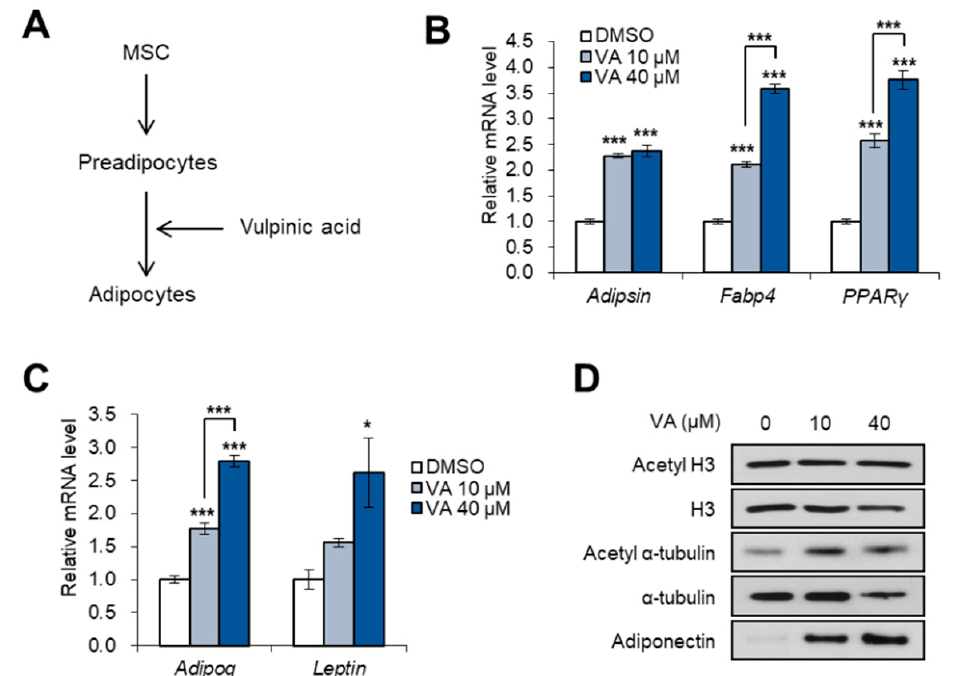
Figure 4. Vulpinic acid promotes adipogenesis from 3T3-L1 preadipocytes. ( A ) Schematic representation of adipogenesis process. 3T3-L1 cells were incubated with an adipogenic medium in the absence or presence of vulpinic acid. ( B ) The mRNA levels of Adipsin, Fabp4, and PPAR γ genes in 3T3-L1 adipocytes incubated with vulpinic acid (10 or 40 μ M) during adipogenesis. ( C ) The mRNA levels of Adipoq and Leptin genes in 3T3-L1 adipocytes incubated with vulpinic acid (10 or 40 μ M) during adipogenesis. ( D ) Immunoblot analysis of 3T3-L1 adipocytes incubated with vulpinic acid (10 or 40 μ M) during adipogenesis. Data represent means ± SEM for n = 3. * p < 0.05, ** p < 0.01, *** p < 0.001.